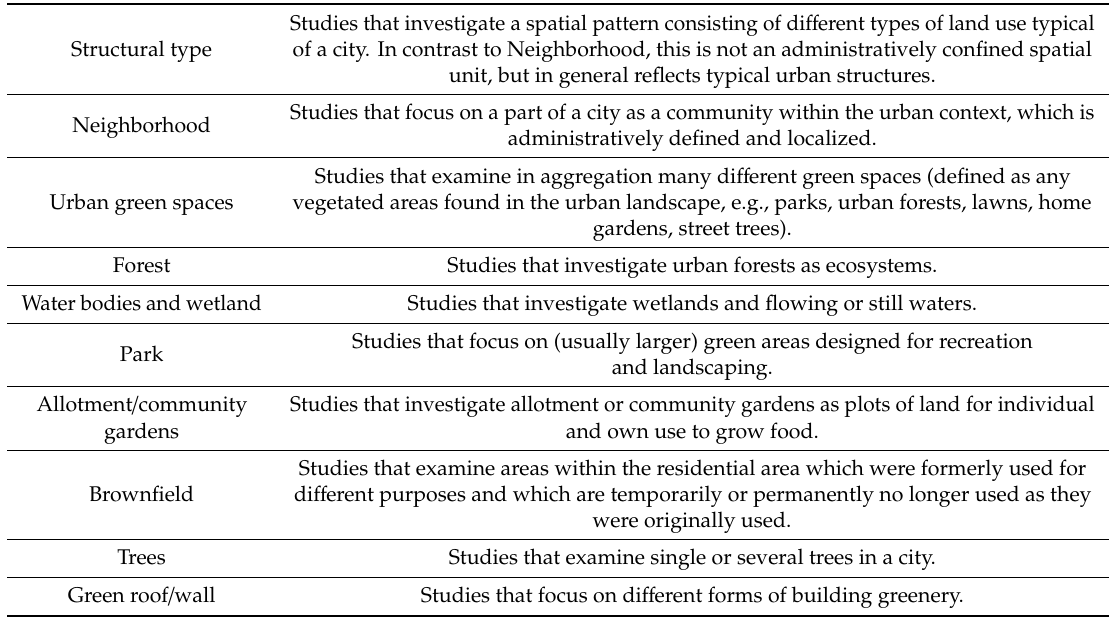
Table 1. Range and definitions of investigated spatial